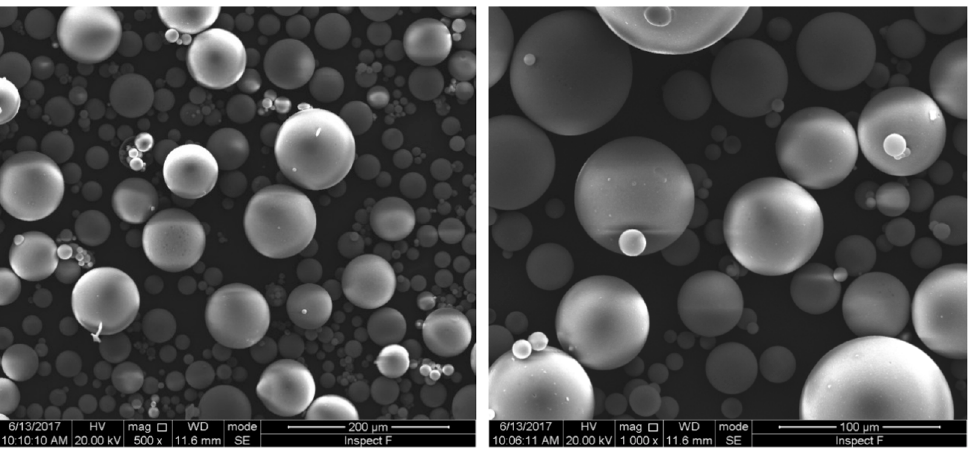
Figure 5. Two SEM (Scanning Electron Microscopy) images of HGM at different magnifications. The size of microbubbles ranges from ~10 μ m to ~100 μ m, most of them being in the interval 30 to 70 μ m. Reproduced from [64] under Creative Commons license.